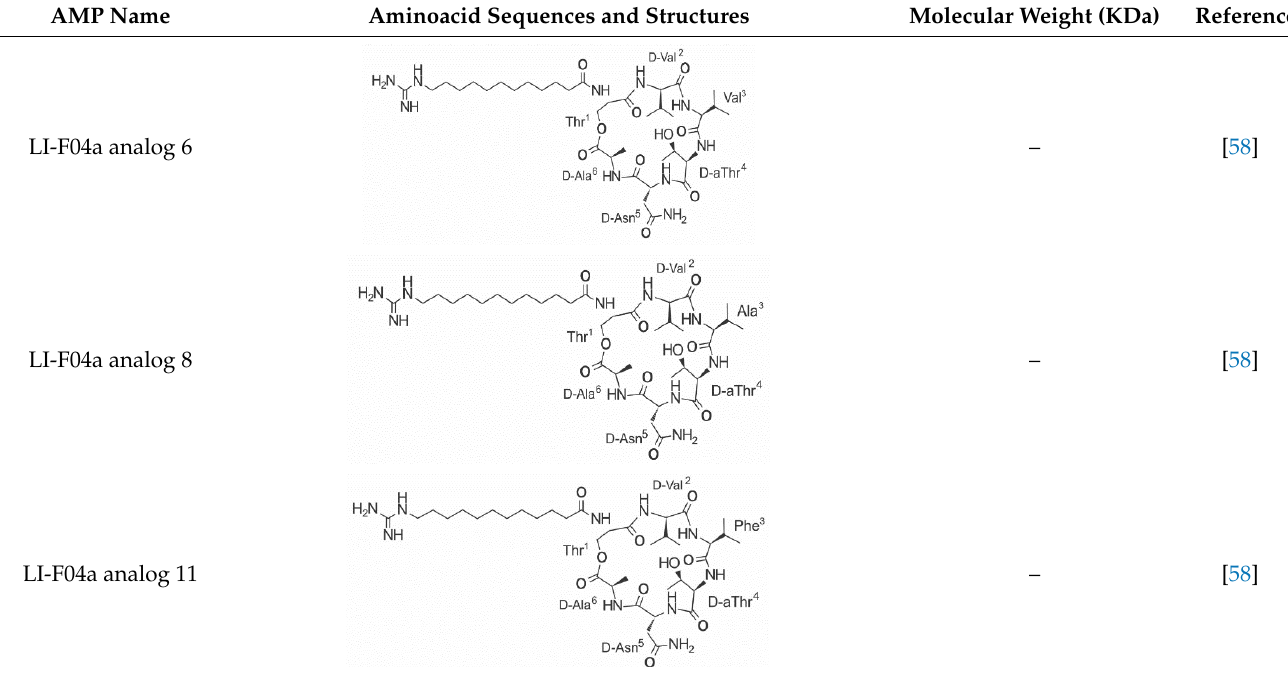
Table 7. Artificial AMPs of atypical structure that showed antibacterial activity against VRSA and VISA strains.